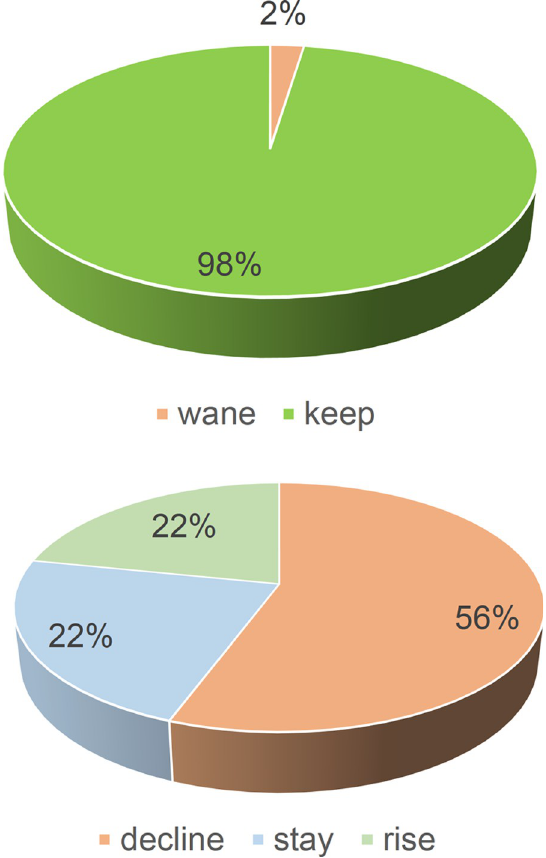
Fig 3. Outcomes of anti SARS-CoV-2 total antibodies. Proportion of donors keeping or waning total immunoglobulins recognizing anti SARS-CoV-2 N protein and donors whose total immunoglobulins recognizing anti SARS-CoV-2 N protein will decline, remain the same or rise. Wane: Positive donor becomes negative; decline: OD under 90% of the previous one; stay: OD +/-10% of the previous one; rise: OD over 110% of the previous one.